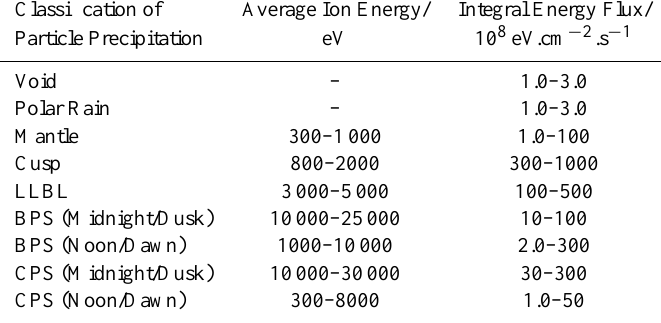
Table 1. Typical average ion energies and integral fluxes used as part of the ionospheric precipitation classification (based on examples given in Newell et al. 1991b, c). Acronyms used: LLBL – Low-latitude Boundary Layer, BPS – Boundary Plasma Sheet, CPS – Central Plasma Sheet. These regions are described in Sect.